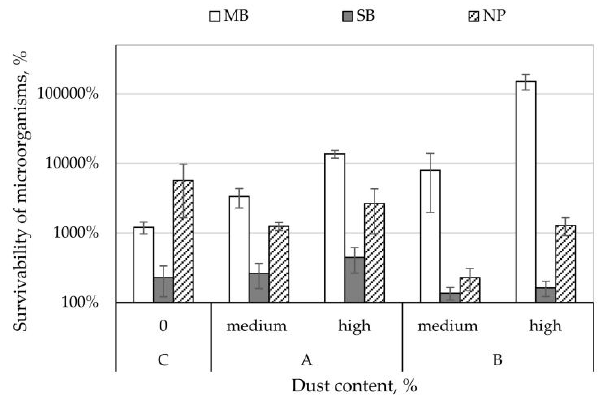
Figure 2. Survivability of Escherichia coli bacteria on the filtering nonwovens depending on dust type and content. Table 4. Number of Candida albicans on filtering nonwovens depending on dust type and content. Nonwoven